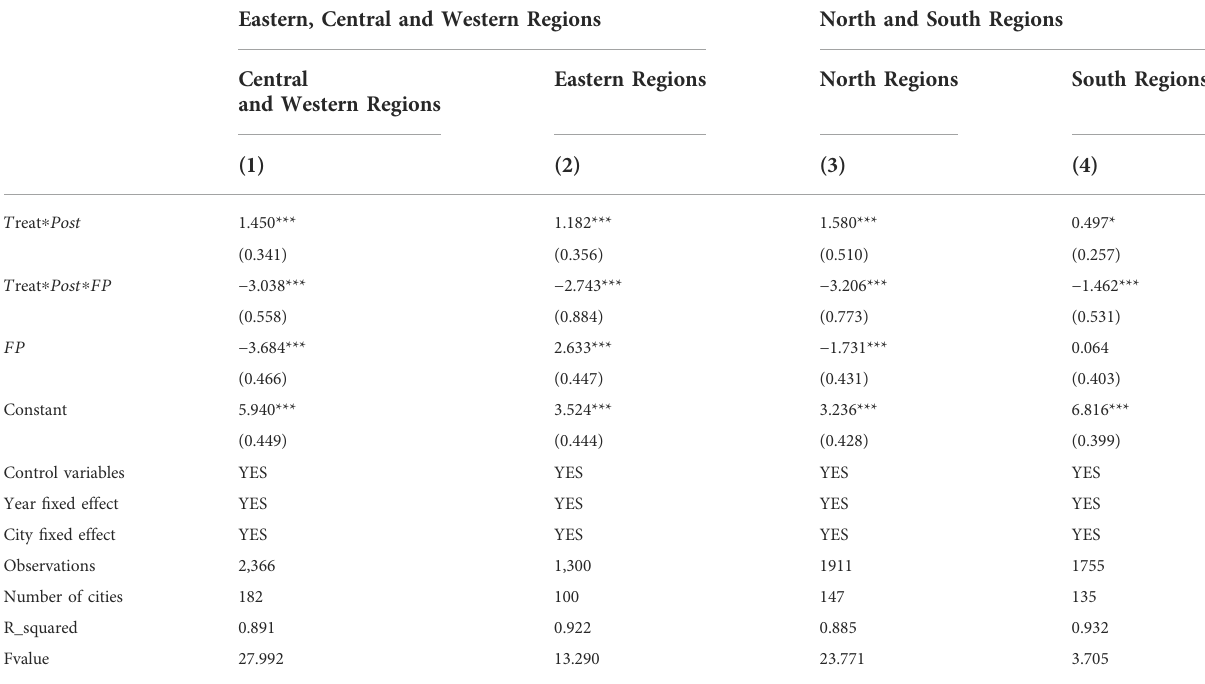
TABLE 7 Estimations under different regional